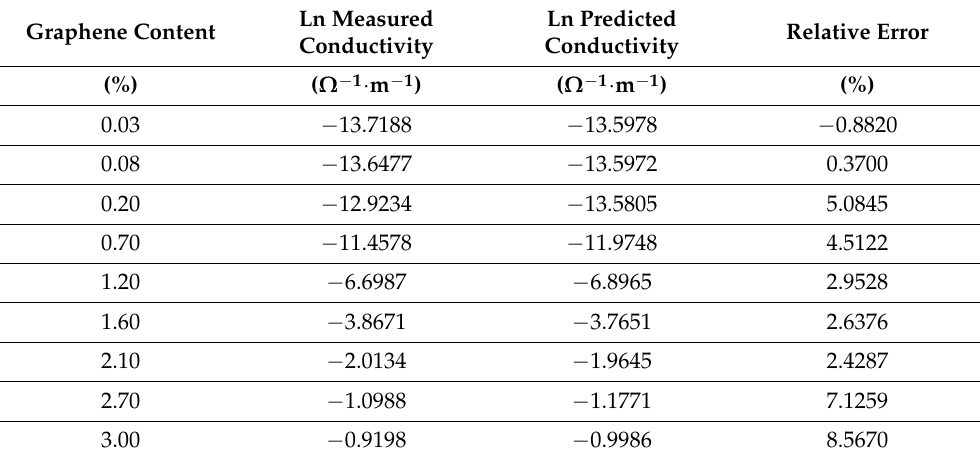
Figure 6. Fi tt ed line for the conductivity vs. graphene content by means of logistic model. Figure 6. Fitted line for the conductivity vs. graphene content by means of logistic model. Table 4. Measured and predicted conductivities for some extra graphene contents. Table 4. Measured and predicted conductivities for some extra graphene